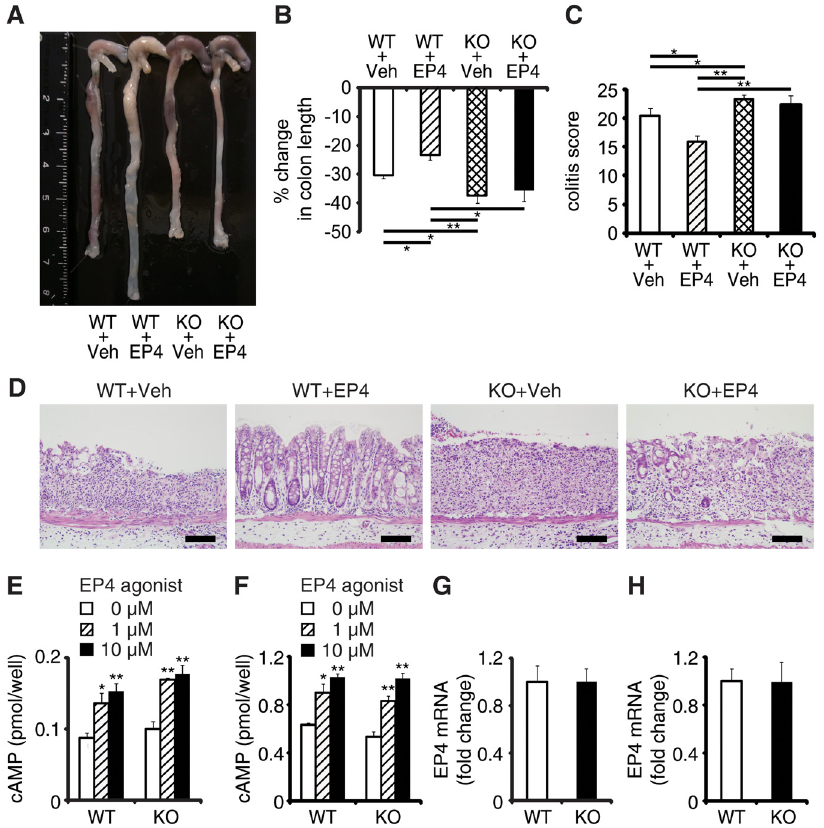
Fig 3. EPRAP deficiency impairs the anti-inflammatory effect of PGE/EP4. (A) Representative photographs of colons; “ Veh ” indicates vehicle and “ EP4 ” indicates EP4 agonist. (B) Percent changes in colon length expressed relative to DSS-free water controls (n = 5 – 8 each; ** P < 0.01 vs. WT + Veh). (C) Histological colitis scores (n = 5 – 8 each; * P < 0.05 vs. WT + Veh). (D) Representative H&E staining. Scale bars: 100 μ m. (E, F) Peritoneal macrophages (E) and colonic epithelial cells (F) isolated from WT and KO mice were incubated with EP4 agonist. Intracellular cAMP levels were measured as described in Supplemental Methods ( * P < 0.05 and ** P < 0.01 vs. 0 μ M). Figures are representative of five independent experiments performed in triplicate. (G, H) EP4 mRNA levels in peritoneal macrophages (G) and colonic epithelial cells (H) from WT and KO mice (n = 6 each). Data represent fold induction of mRNA expression compared with WT. All values represent means ±